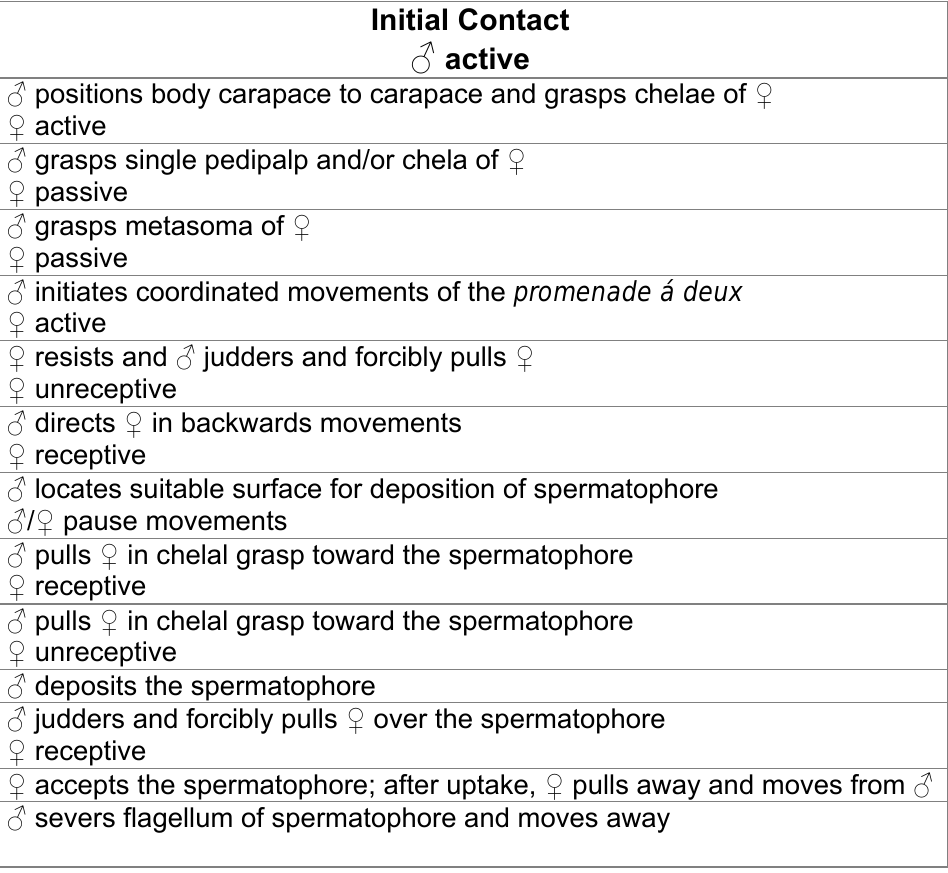
Figure 1. Ethogram demonstrating the behavioral components of the courtship sequence in Tityus ( Atreus ) magnimanus